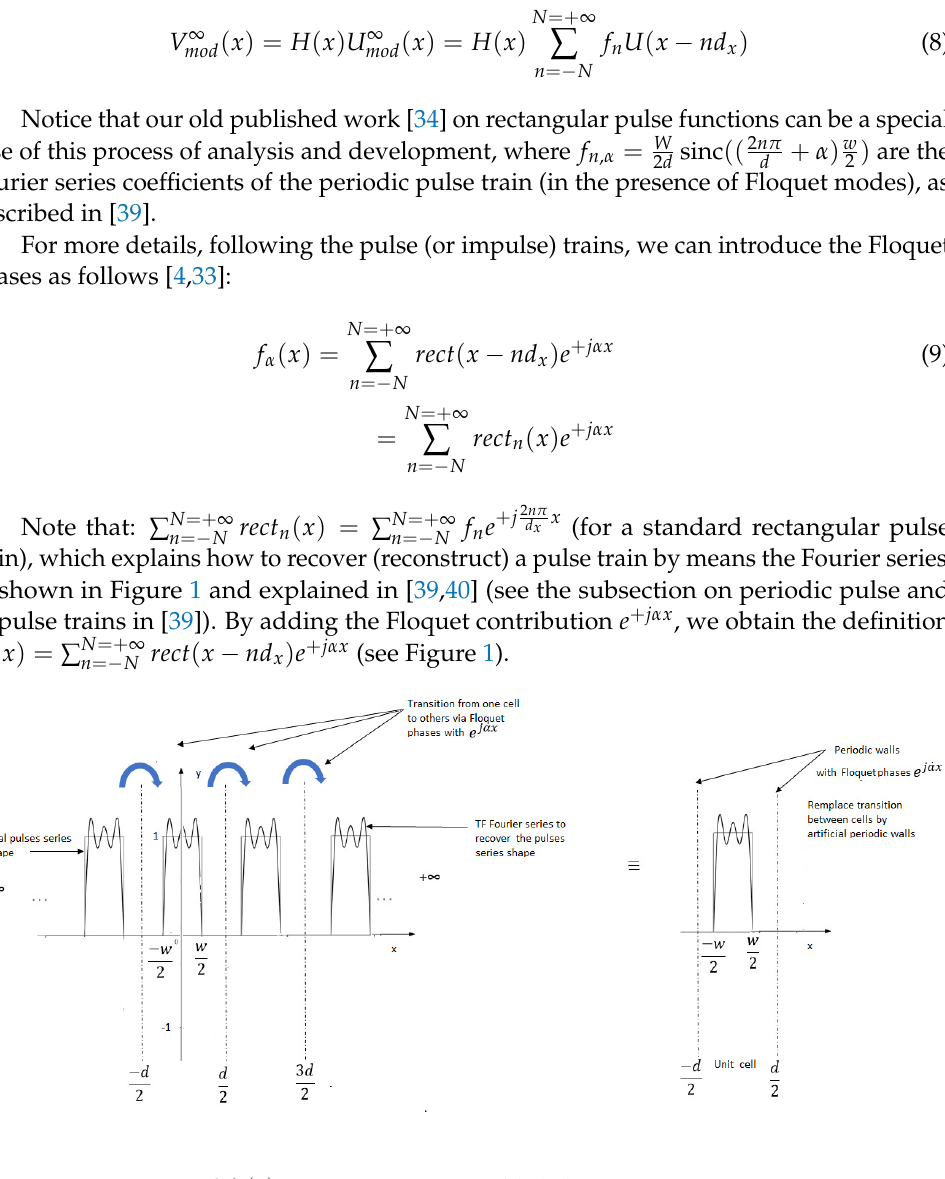
Figure 1. Construction of f α ( x ) as given in Equations (9)–(11). Rect is a rectangular function with a width